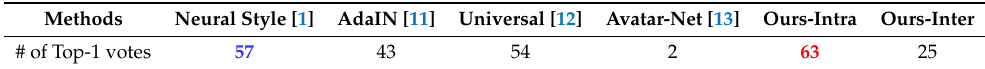
Table 2. Top-1 votes of the style transfer methods. The red and blue colored values represent the best and the second best performances